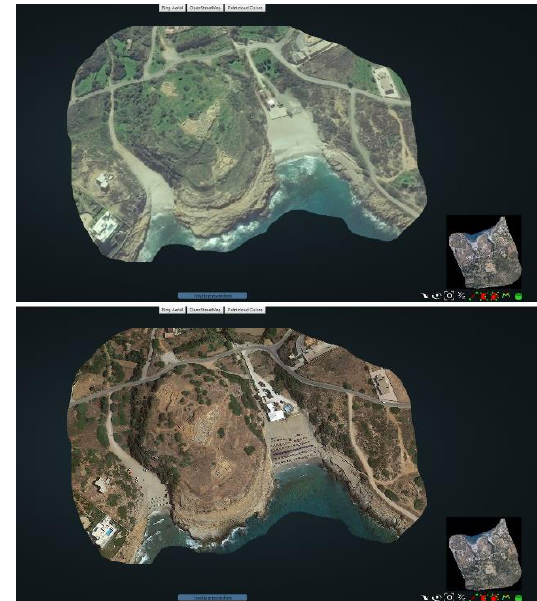
Figure 7: 3D point-cloud with two different colour textures (from original aerial photographs and from Bing provided